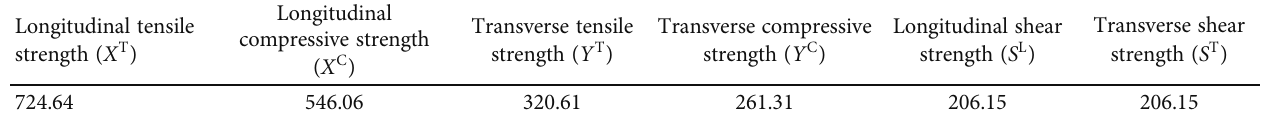
Table 4: Failure properties of stack components [6].